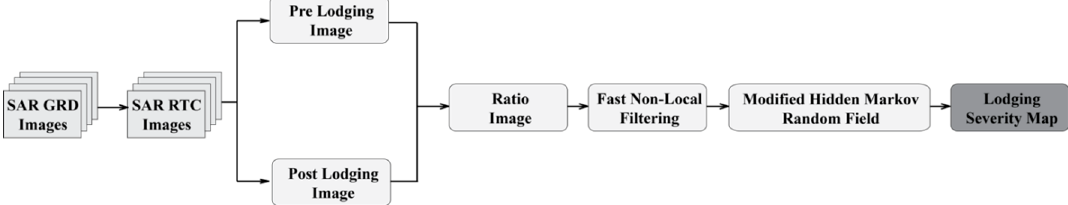
Figure 4. Approach for mapping the 2020 Derecho lodging disaster.